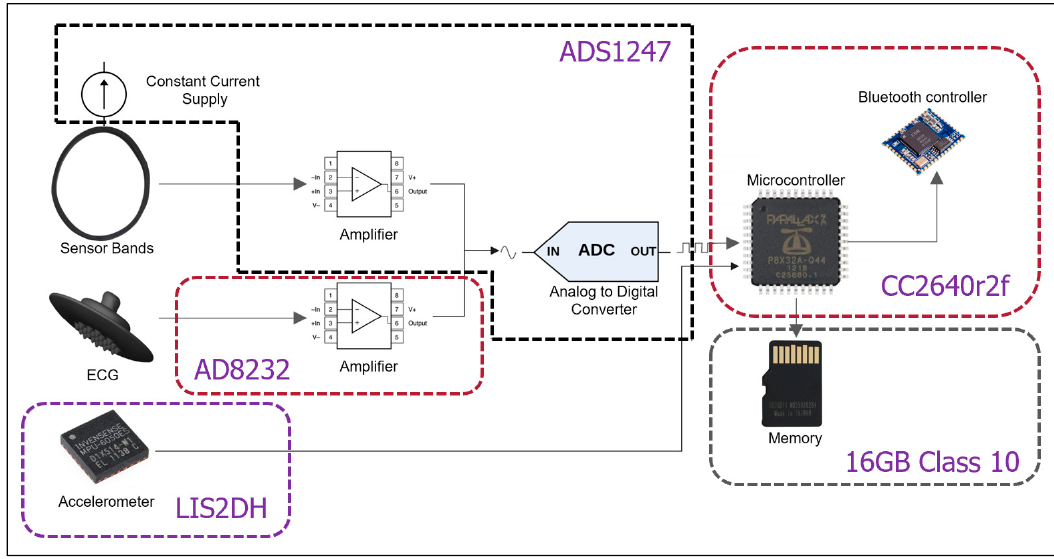
Figure 2. Components inside the T-shirt.